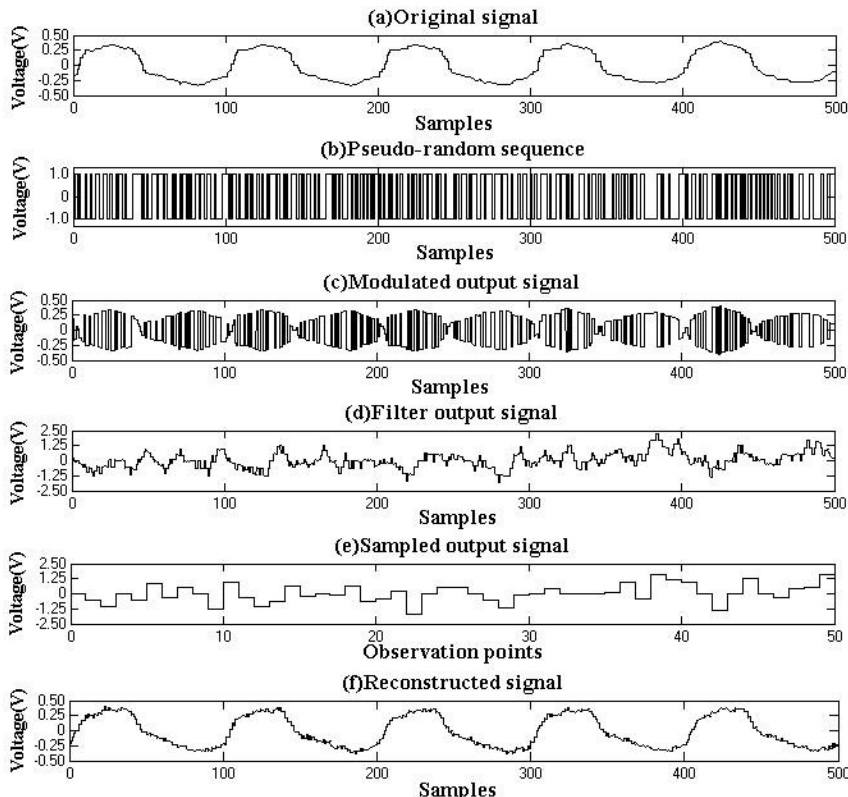
Figure 6. Experiment